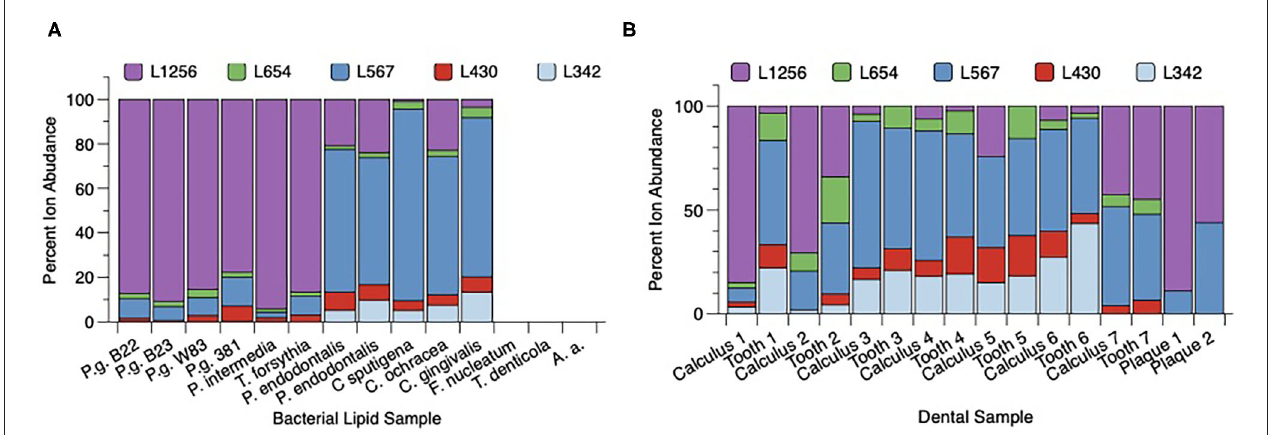
FIGURE 3 | Distribution of serine/glycine lipids in subgingival organisms and dental samples. (A) Bacteria were grown in broth culture and processed as described in section Materials and Methods. Individual bacterial lipid extracts were analyzed by LC-MS as described in section Materials and Methods. Recovery of individual lipid classes is depicted as a percent of the total serine/glycine lipids recovered in each bacterial lipid sample. Serine/glycine lipids were recovered in Porphyromonas gingivalis (P.g.), Prevotella (P.) intermedia , Tannerella (T.) forsythia, Porphyromonas endodontalis, and three Capnocytophaga (C.) species. Serine/glycine lipids were not detected in Fusobacterium (F.) nucleatum, Treponema (T.) denticola or Aggregatibacter actinomycetemcomitans (A.a.). (B) Recovery of serine/glycine lipids in lipid extracts from paired tooth/subgingival calculus samples, and lipid extracts from two pooled subgingival plaque samples isolated from two patients with generalized severe periodontitis. Seven hopeless teeth diagnosed with severe chronic periodontitis were extracted and the teeth were lyophilized. Dark subgingival calculus was removed from each tooth using sterile scalers and the paired tooth/subgingival calculus samples were individually extracted. Frame B compares the percent serine/glycine lipid recovery for each paired calculus and tooth sample. Except for tooth 1, the distribution of serine/glycine lipids is similar between subgingival calculus and tooth samples. Paper point samples were collected using sterile endodontic paper points inserted into interproximal pockets and were pooled for two individual patients demonstrating generalized severe chronic periodontitis. The paper point samples were then extracted for total lipids as described in section Materials and Methods. Lipid 567 and Lipid 1256 were the only serine/glycine lipids detected in lipid extracts from pooled subgingival plaque